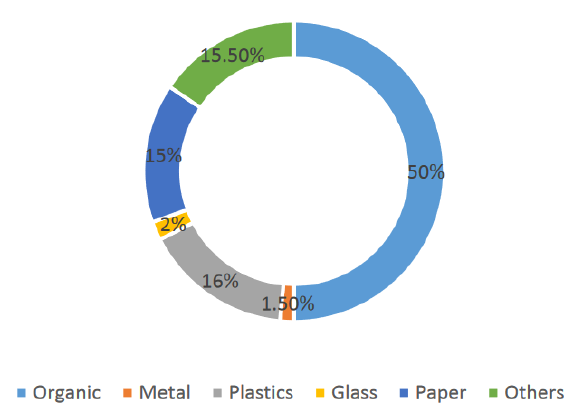
Figure 1. Composition of different types of MSW in Jordan from GIZ (2014)